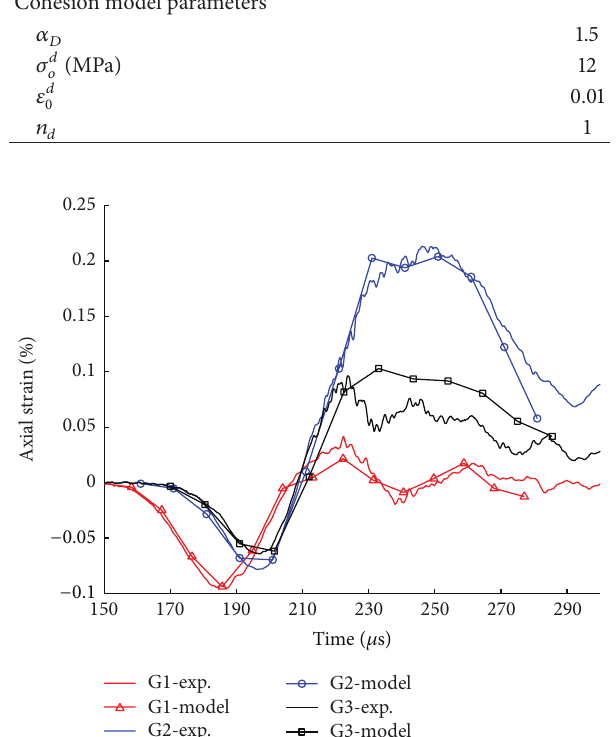
Table 2: Material parameters used in the cohesion model. Cohesion model parameters